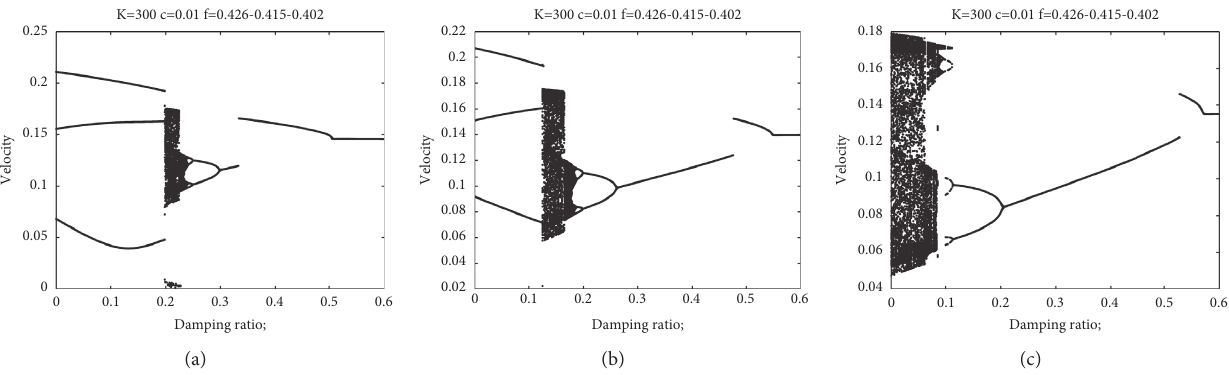
Figure 18: Influence of beam structure damping ratio. (a) f � 0 . 402 Hz, (b) f � 0 . 415 Hz, and (c) f � 0 . 426